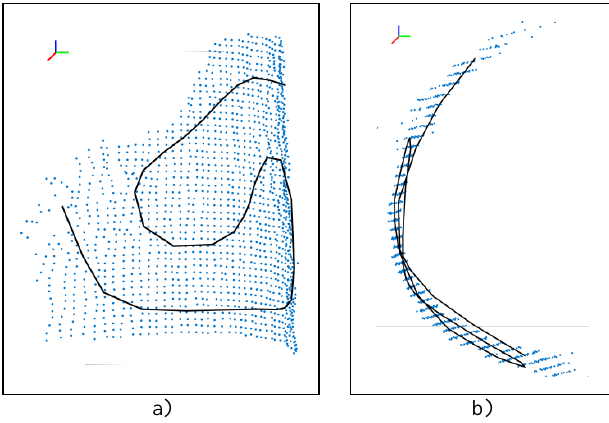
Figure 11. 3D point set represents a surface patch without a distinct principal direction; therefore, the polygonal line algorithm minimizes error by embedding a curvy polyline. a) Front view. b) Top